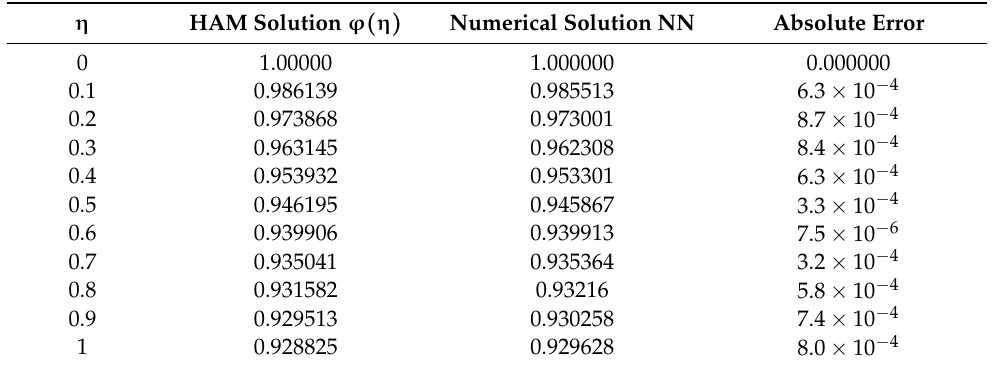
Table 3. Comparison between HAM and numerical solutions are shown for concentration field ϕ ( η ) when (cid:125) = − 0.25, P r = 10, B r = 0.1, N r = 0.1, D u = 0.1, S c = 0.1, ε = 0.1, S r = 0.1, λ = 0.1, Λ = 0.1, β = 1, S =